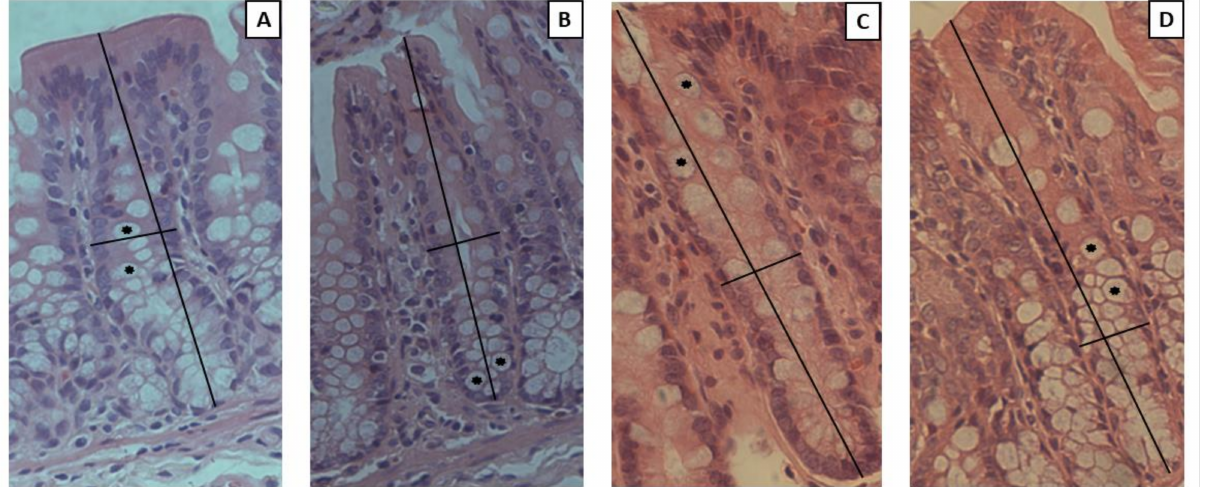
Figure 9. Representative photomicrographs of cecum sections after 10 weeks of treatment. ( A ) AIN- 93M; ( B ) HFHF; ( C ) GTK; ( D ) BTK. Vertical lines indicate crypt depth; horizontal lines indicate crypt width; asterisks indicate goblet cells. All images were captured in a 20X objective. AIN-93M: standard diet (negative control group); HFHF: high-fat and high-fructose diet (positive control group); GTK: HFHF diet + green tea kombucha diluted in water (30% v / v ); BTK: HFHF diet + black tea kombucha diluted in water (30% v / v